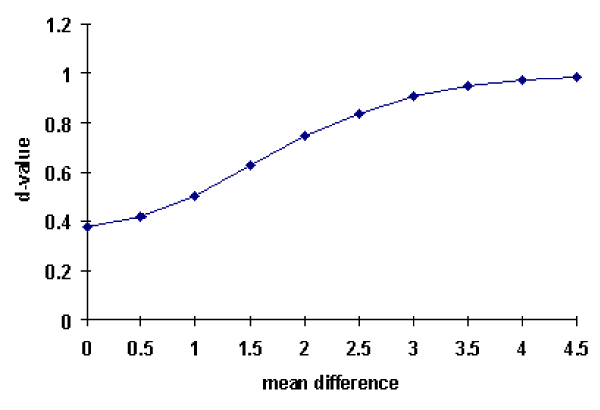
Relationship between the mean difference of distributions and d-value. Two datasets are generated from two distributions. Let N(0,1) and N(x, 1) be two normal distributions, where x is the mean difference between these two distributions. In this experiment, we consider x = 0, 0.5, 1, 1.5, 2, 2.5, 3, 3.5, 4, 4.5, respectively. The d-value between two sets increases when the mean difference of two data sets increases.